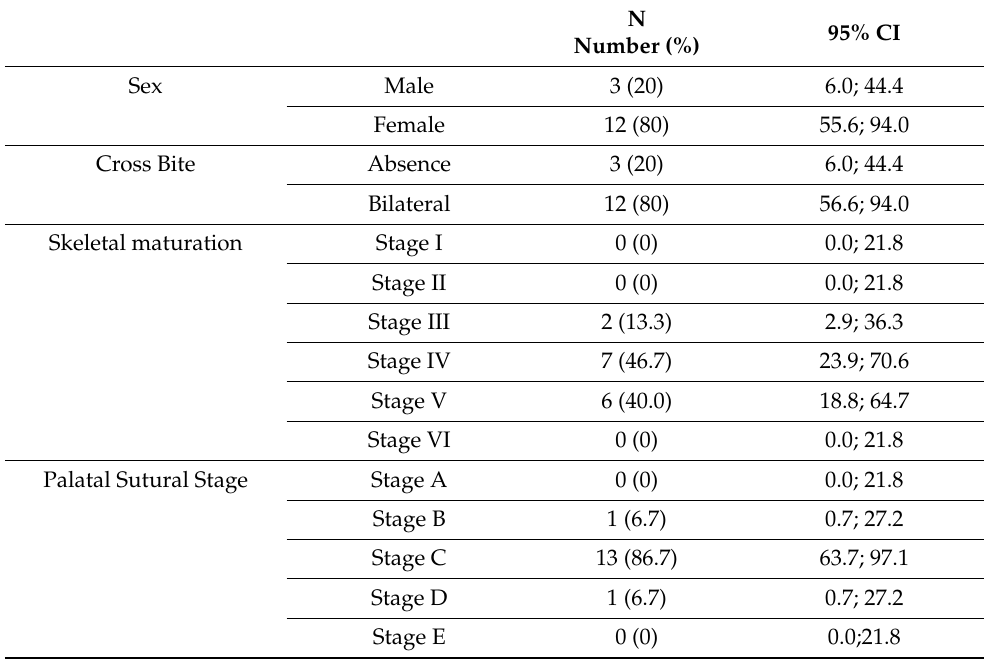
Table 5. Sample sex, cross bite, skeletal maturation and palatal sutural stage